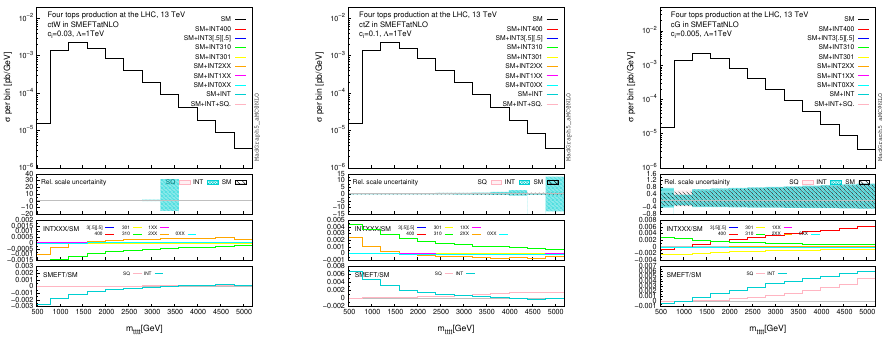
Figure 24 . Same as figure 11 but for the rest of the contributing two-fermion and purely-bosonic operators.